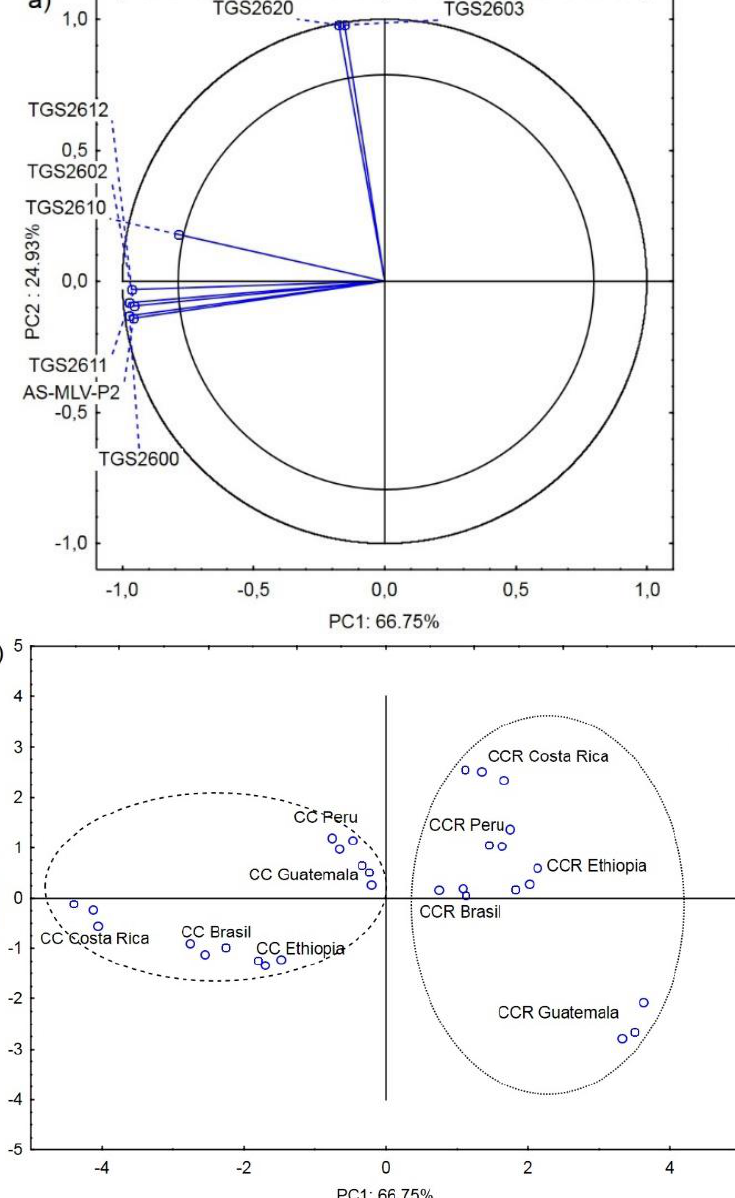
Figure 3. Projection of loadings (maximum responses of sensors characterizing the CC and CCR coffee roasting process) on the PC1 and PC2 factor plane — ( a ); projection of cases (coffee beans from Brazil, Ethiopia, Guatemala, Costa Rica, and Peru roasted in CC and CCR roasters) on the PC1 and PC2 factor plane — ( b ).